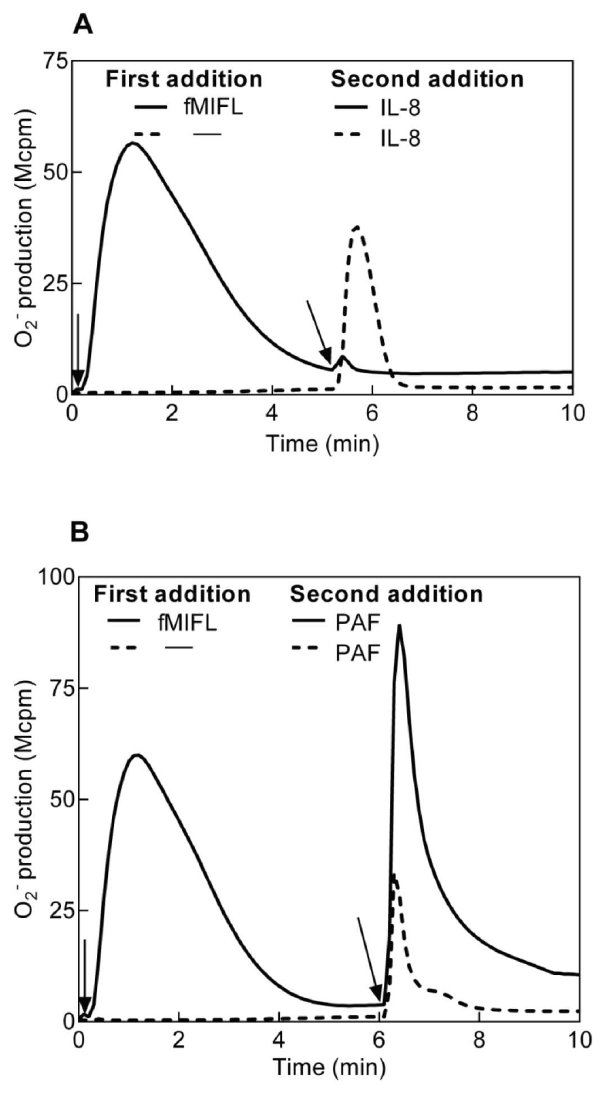
Figure 1. Receptor cross talk between neutrophil FPR1 and PAFR/CXCR1/2 determined as superoxide production. Human neutrophils desensitized with fMIFL were cross-desensitized to IL8 ( A ) but primed in their response to PAF ( B ). Neutrophils (10 5 cells, 37 u C) were first activated by the FPR1 specific agonist fMIFL (0.1 nM, added at time indicated by the arrows to the left) leading to receptor desensitization (solid lines in A and B ). A second stimulus ( A ; IL8, 100 ng/ml, B ; PAF, 100 nM) was added to the cells (solid lines) at the time point indicated by the arrows to the right. Activation of naı¨ve (non-desensitized) neutrophils by IL8 ( A ) and PAF ( B ) was determined in parallel and is shown for comparison (broken lines). A representative experiment is shown, n . 5. Abscissa, time of study (min); Ordinate, superoxide production (counts per minute 6 10 6 ; Mcpm).